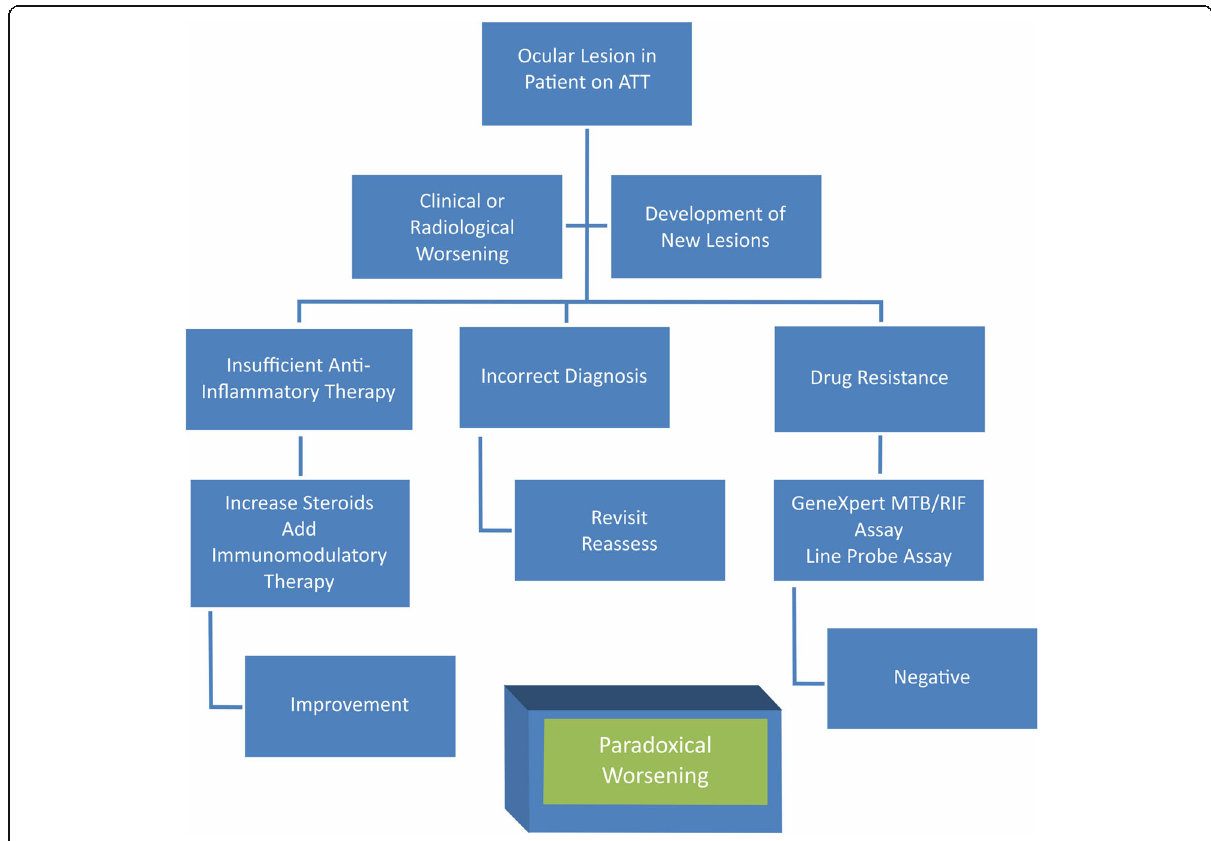
Fig. 5 Paradoxical worsening of TB — a management